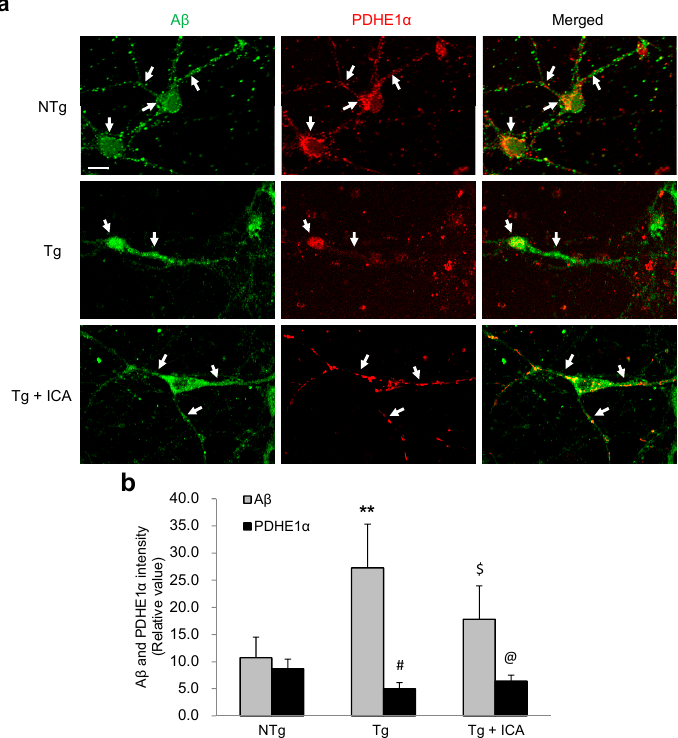
Figure 5. Double-labeling analysis of A β and PDHE1 α in neurons treated with icariin. ( a ) NTg neurons exhibited a moderate labelling of A β with an abundant expression of PDHE1 α in the cytoplasm and neurites (white arrows). In Tg cells the overexpression of A β in the soma and neurites was correlated with a weaker signal in PDHE1 α staining (white arrows). Icariin-treated Tg cells showed increased PDHE1 α expression in the neurites, accompanied with a downregulation of A β (white arrows); ( b ) Quantification of A β and PDHE1 α immunoreactivity showed a higher expression of A β and a lower expression of PDHE1 α in Tg neurons relative to NTg cells, which was reversed by treatment with icariin. Bar graphs (means ± SD) represented three independent experiments. ** p < 0.01 vs. A β level in NTg neurons; # p < 0.05 vs. PDHE1 α level in NTg neurons; $ p < 0.05 vs. A β level in Tg neurons; @ p < 0.05, vs. PDHE1 α level in Tg neurons . Scale bars in ( a ) = 20 μ m.